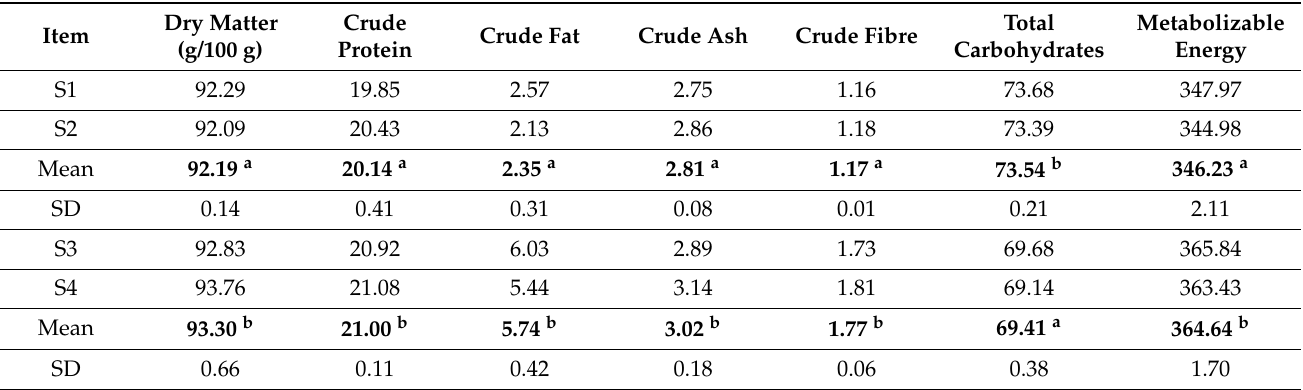
Table 3. Proximate composition (g/100 g DM) and metabolizable energy (kcal/100 g) of extruded (S1, S2) and baked (S3, S4) dog snacks.